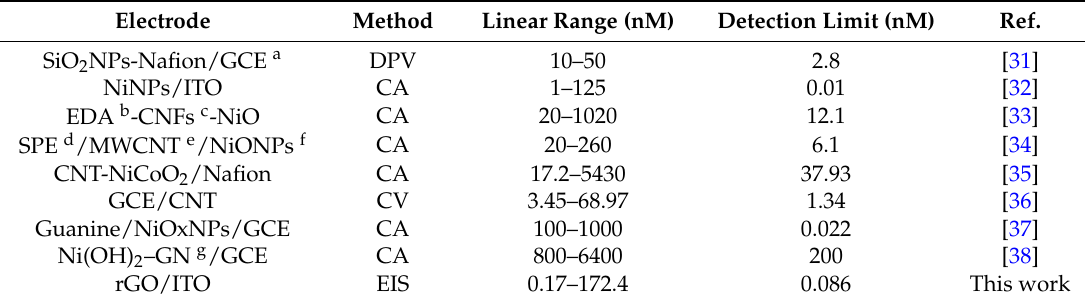
Comparison of the response characteristics of different modified electrodes for insulin